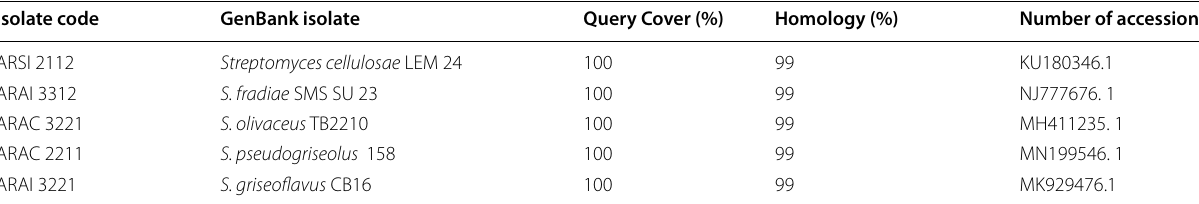
Positive reaction, Negative reaction + − Table 5 Sequence homology of 16sRNA 4 Selected isolates by the accession of GenBank Isolate